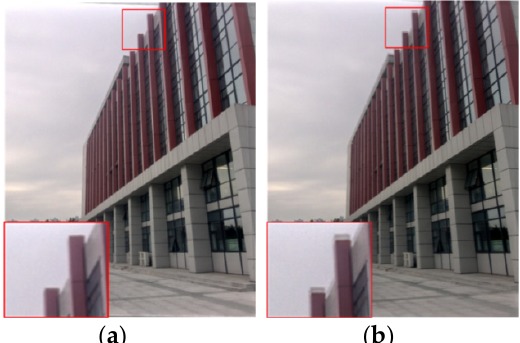
Figure 9. The comparison of image fusion results. ( a ) Fusion result of raw images; ( b ) Fusion result of JPEG images.